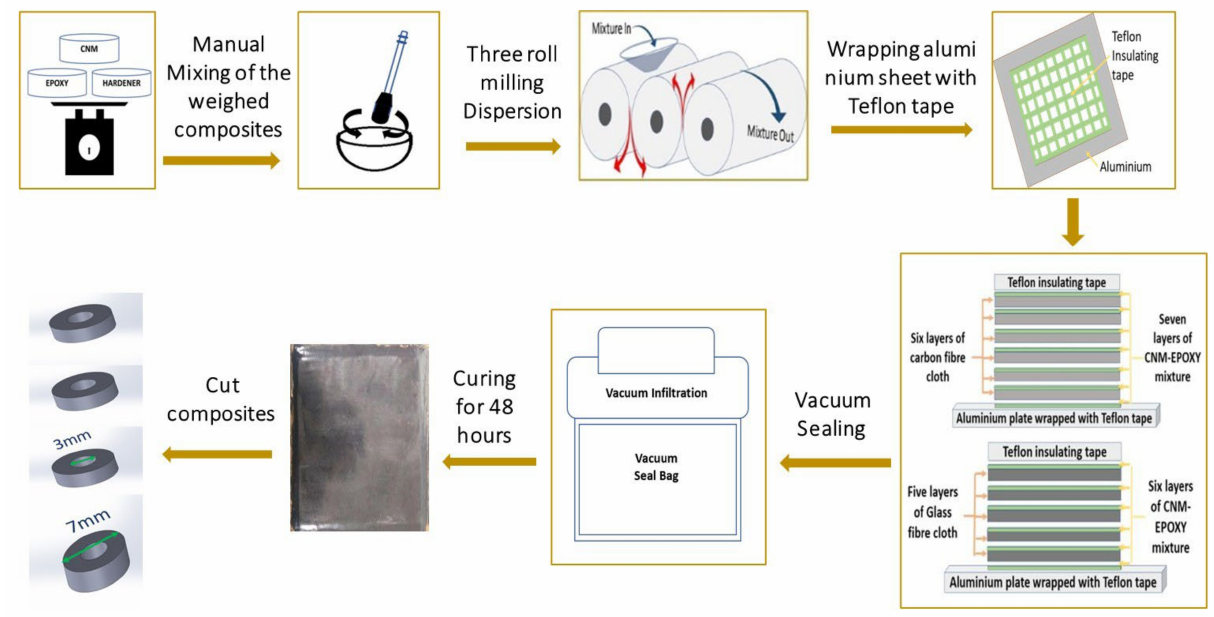
Figure 1. Fabrication of CNM-incorporated CFRP or GFRP